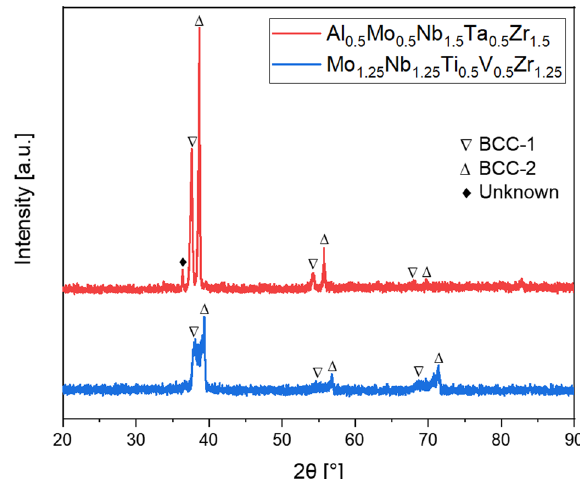
Fig. 7 XRD patterns for the predicted compositions. The two BCC phases could be related to the segregated microstructures observed in the EDX maps, which may contribute to the high strengths of the alloys due to the solid-solution strengthening effect and the second phase strengthening effects. For comparison and consistency, note that (according to Table 13 of 17 ) the training set consisted of a combination of single-phase and multi-phase — mostly BCC compositions. A Panalytical Empyrean X-ray diffract- ometer, at Cu K α radiation, was used to identify the crystal structure of the